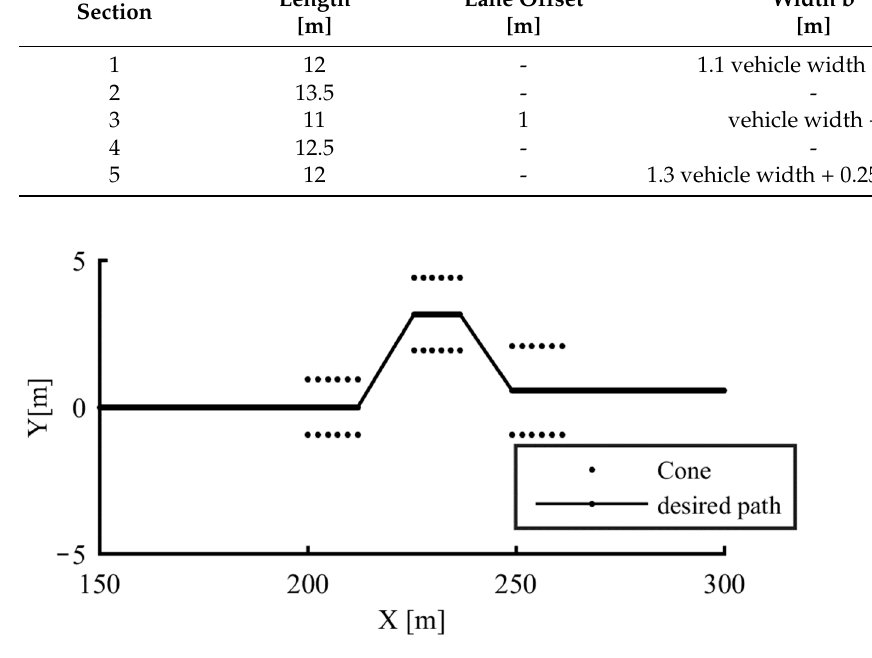
Figure 5. SLC desired trajectory.